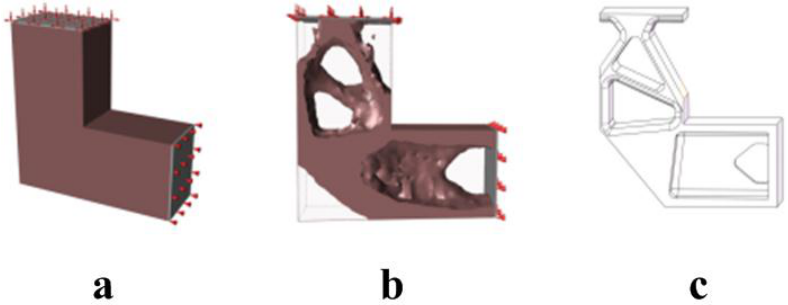
Figure 17. The original L-shape model ( a ), L-shape frame obtained by topology optimization ( b ), the final L-shape frame after optimization ( c ).